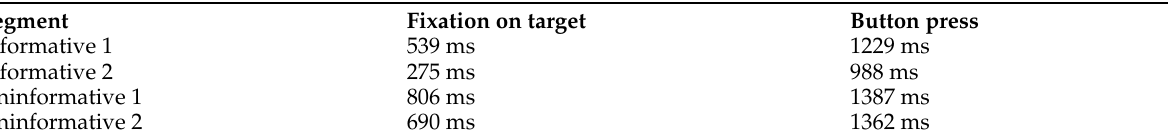
Mean times to first fixation on target and button press.